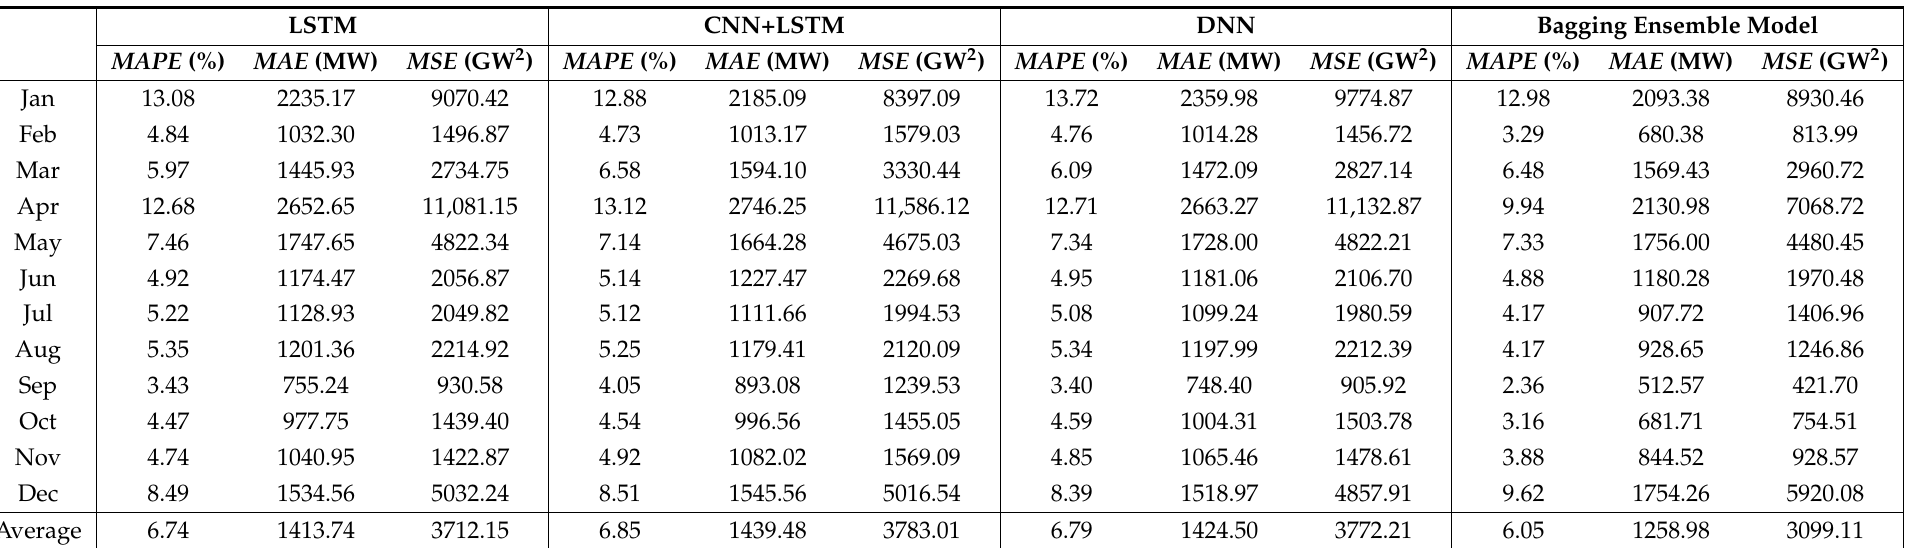
Table 2. Error Measurements of Test Data for Five Input Features in